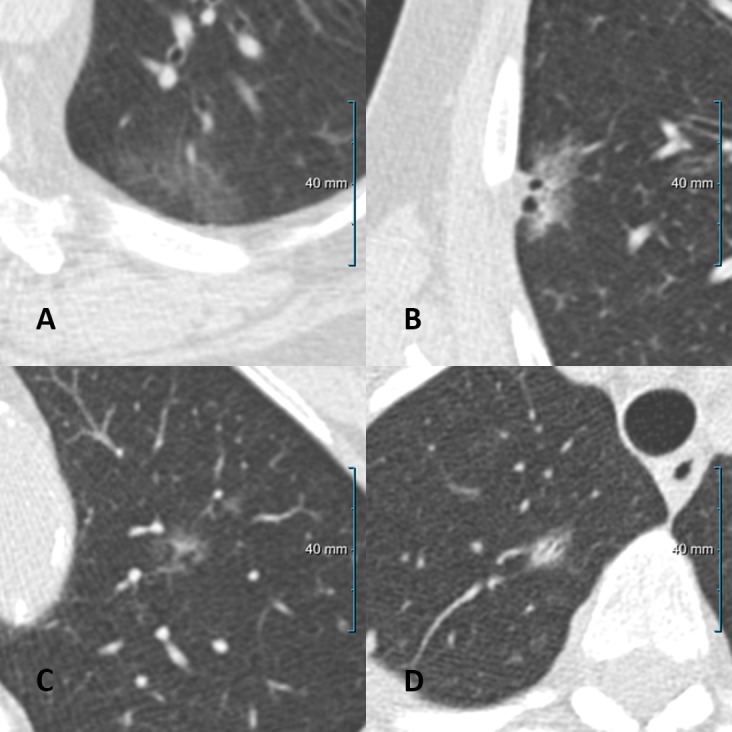
(a) Correctly identified transient lesion with a probability score of ≤ 40 by all four observers. (b) Correctly identified persistent lesion with a probability score of ≥ 80 by all four observers. (c) Incorrectly identified lesion by majority of observers: transient lesion, but scored as persistent (probability score ≥ 60). (d) Incorrectly identified lesion by majority of observers: persistent lesion, but scored as transient (probability score ≤ 40).